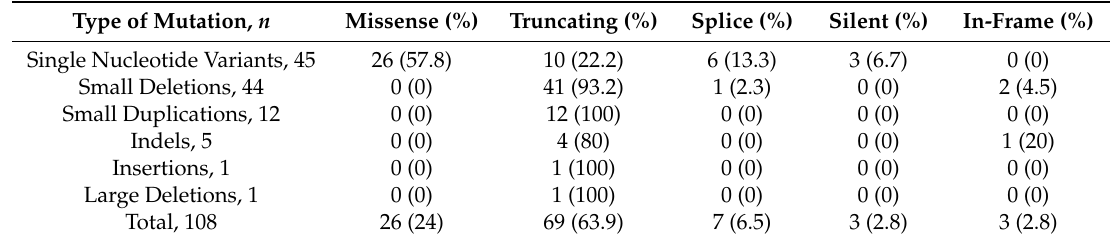
Table 1. Classification of the previously undescribed NF1